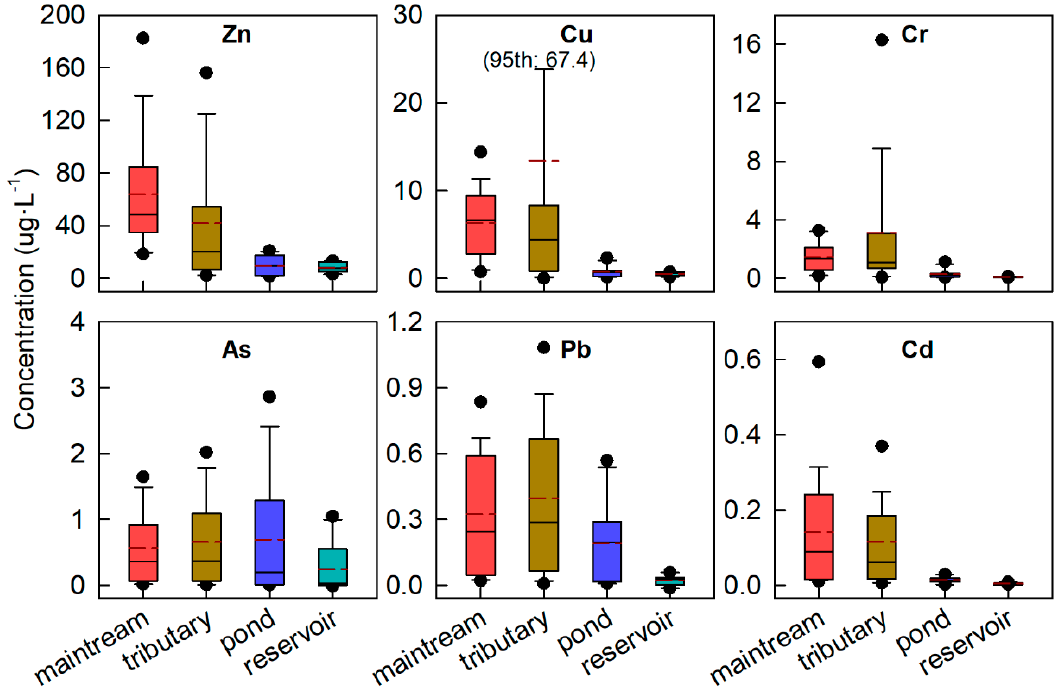
Figure 2. Dissolved metal(loid) concentrations of different water types in the Maozhou River watershed in Shenzhen, China. The boxplots show the 5th, 10th, 25th, 50th, 75th, 90th, and 95th percentiles of the data; the red dashed lines indicate the average values.